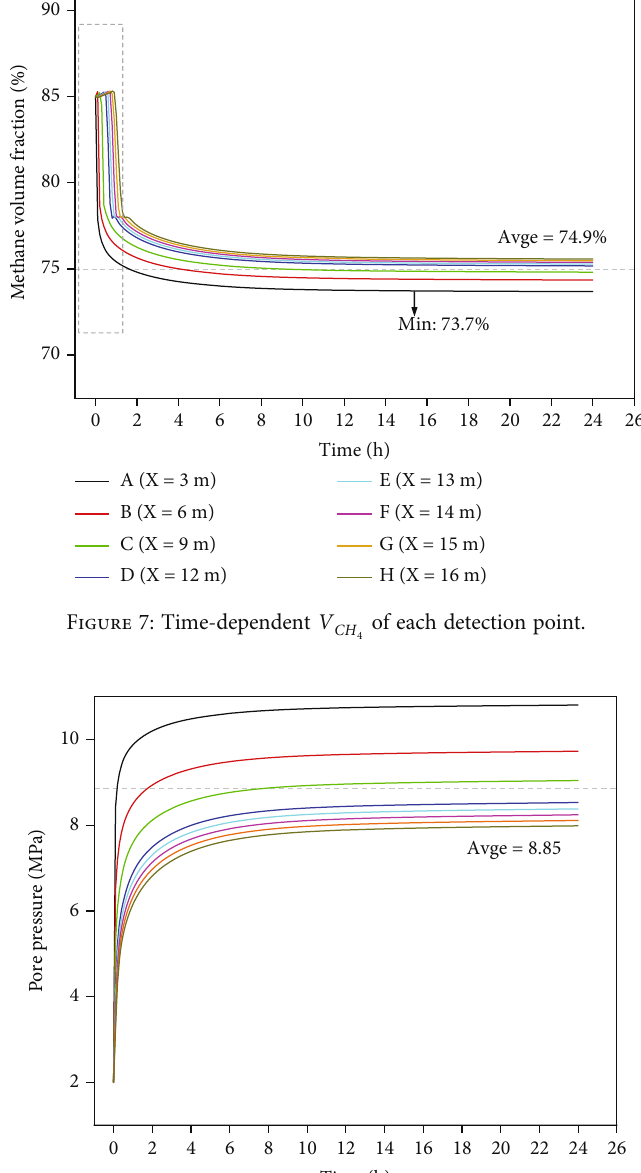
Figure 8: Time-dependent pore pressures at each detection